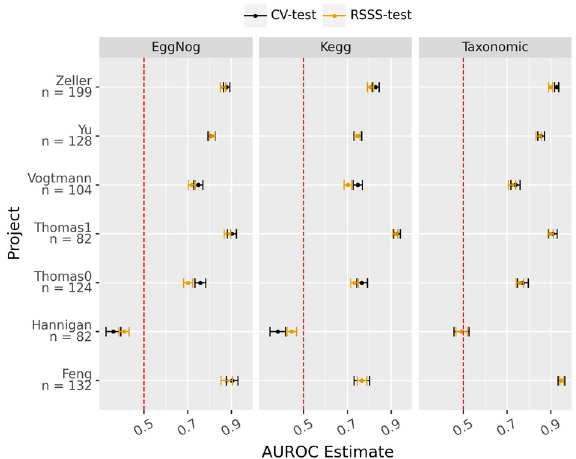
Figure 3. Mean of the area under the receiver operating characteristic curve (AUROC) along with the 0.25 and 0.75 quantiles for the Random Stability Sub Sampling (RSSS-test) and 20-times tenfold cross validation (CV-test) splitting schemas when discriminating between CRC and healthy samples for each metagenomic profile (KEGG, eggNog and taxonomic) and